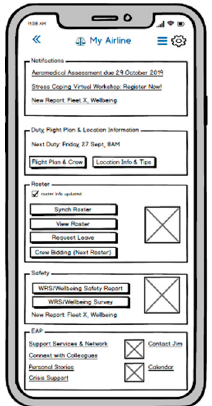
Figure A10. Tool 1: my airline dashboard.